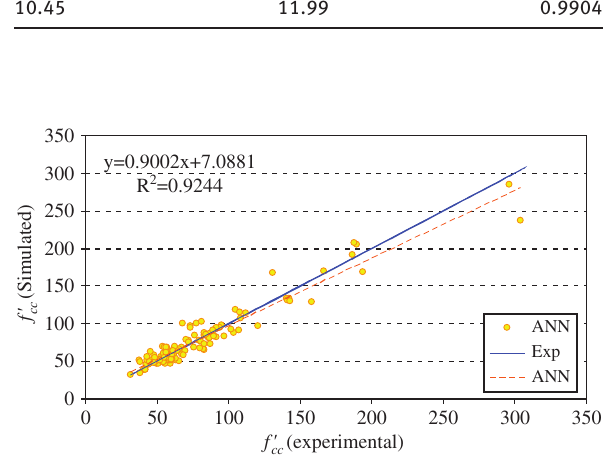
Figure 13 Predictions of the ANN model against experimental